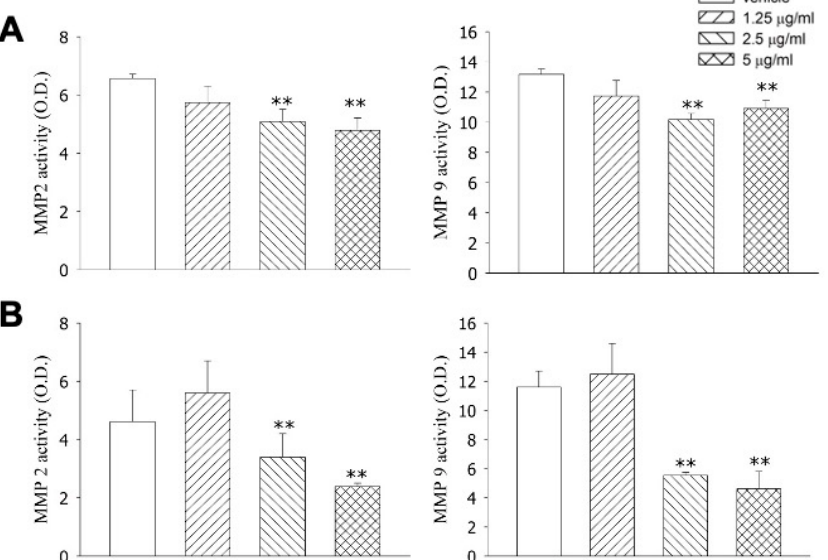
Figure 4. Effects of tagitinin C on MMP2 and MMP9 activity based on a collagen zymography assay. ( A ) Effects of tagitinin C on MMP2 and MMP9 activity in Hep-G2 cells. ( B ) Effects of tagitinin C on MMP2 and MMP9 activity in Huh 7 cells. ** p < 0.01 vs. control.